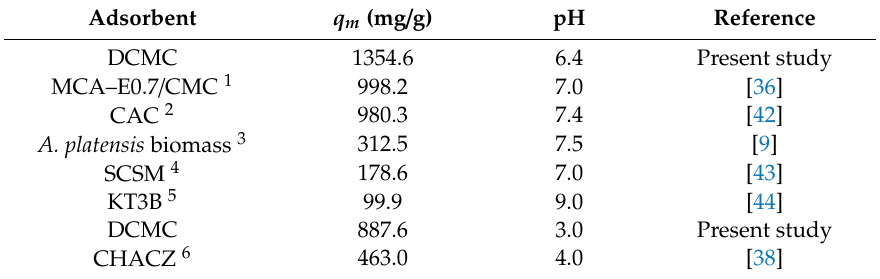
Table 5. Comparison of maximum adsorption capacity of methylene blue with other